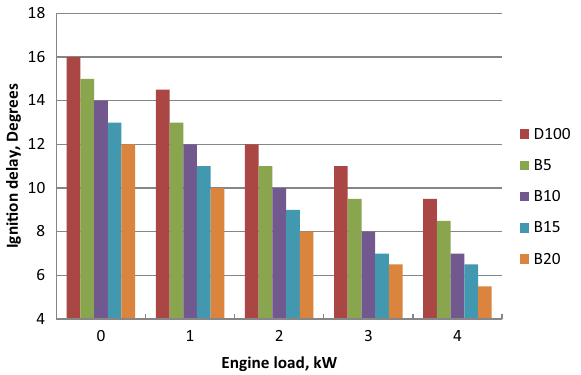
Figure 10. Effect of palm ethyl ester mixtures on ignition delay at engine load variation.